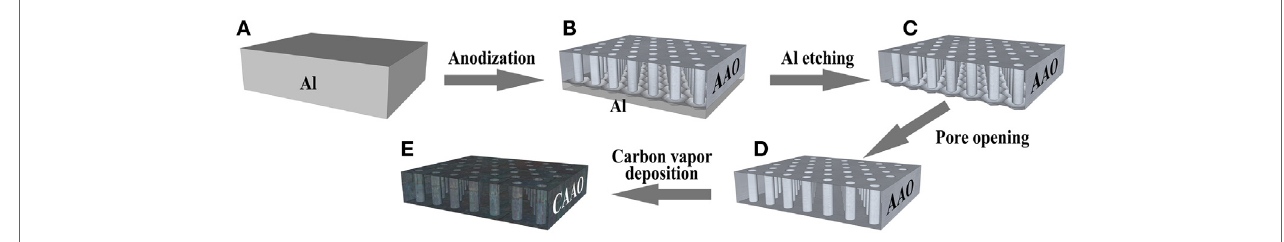
FigUre 1 | scheme of the preparation of the carbon-coated anodic aluminum oxide films . (a) A polished Al foil, (B) an anodic aluminum oxide (AAO) film on the Al substrate, (c) an AAO film, (D) an AAO film with pores open on both sides, and (e) a carbon-coated AAO